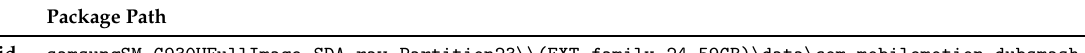
Table 5. Dubsmash app package paths.